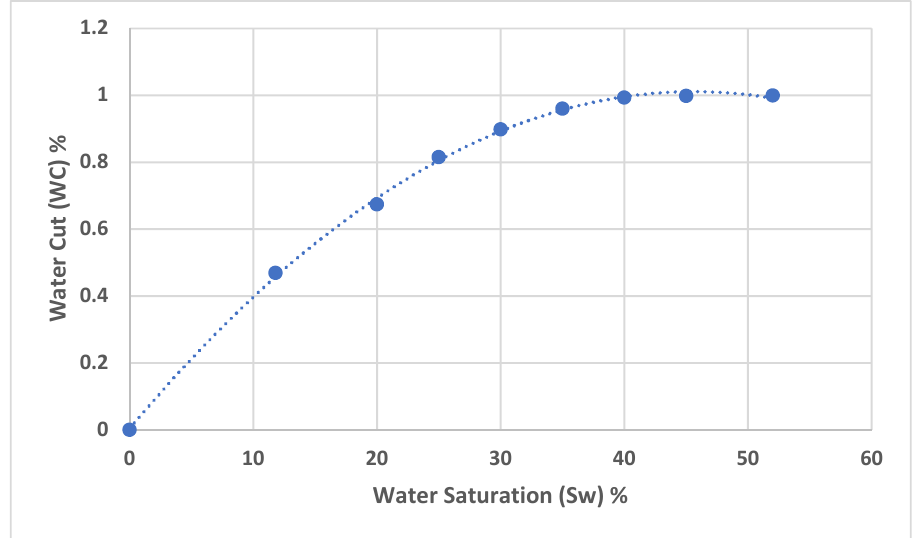
Figure 15. Fractional flow or water cut with water saturation in the displacement of oil by water. A fractional flow curve (Fw versus Sw) is utilized to characterize the immiscible fluid displacement operation. Developing an illustrative fractional flow curve for a specific res ‐ ervoir perfectly may be challenging after a liquid and special core information analysis has been performed. Then, the technique that measures fractional flow curve from the historic production information must be used. The curve becomes the primary one for a similar model that permits the estimations of oil rate production and reserves for present or proposed wells. The relative permeabil ‐ ity curves can be formed mainly due to the resultant fractional flow curve. A comparison of relative permeability curves can be made from the special core analysis information, which may raise confidence.